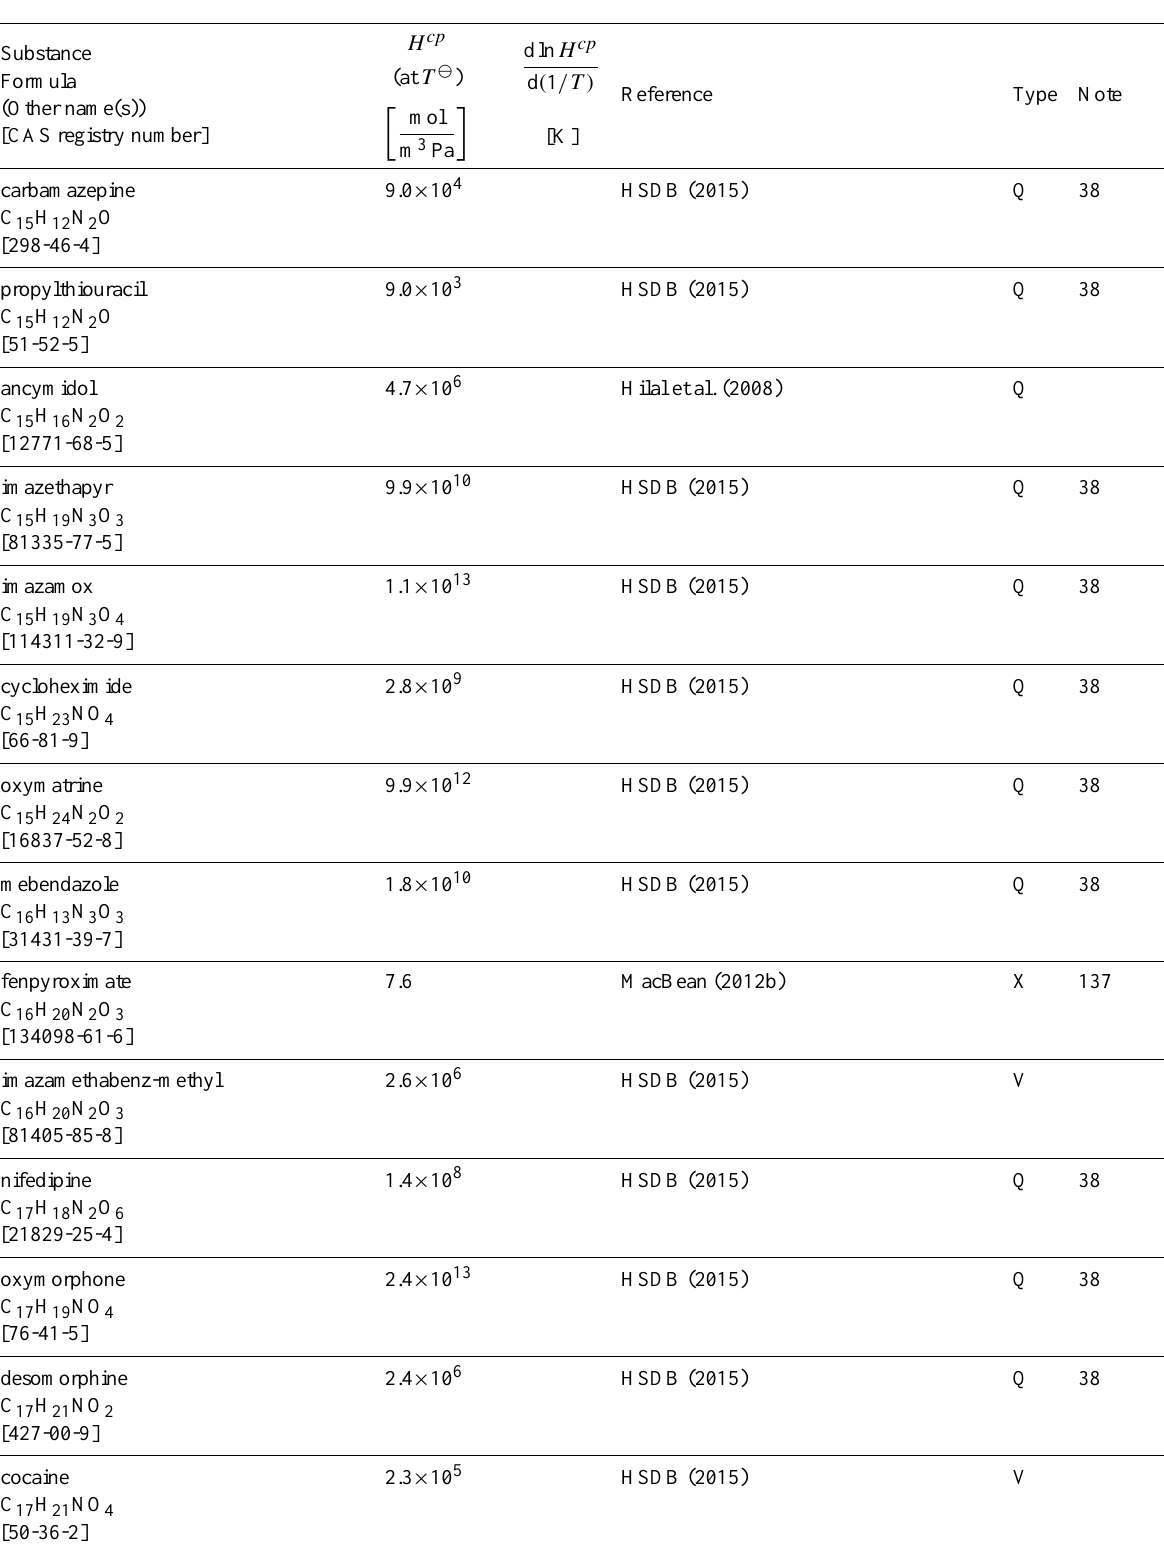
Table 6: Henry’s law constants for water as solvent